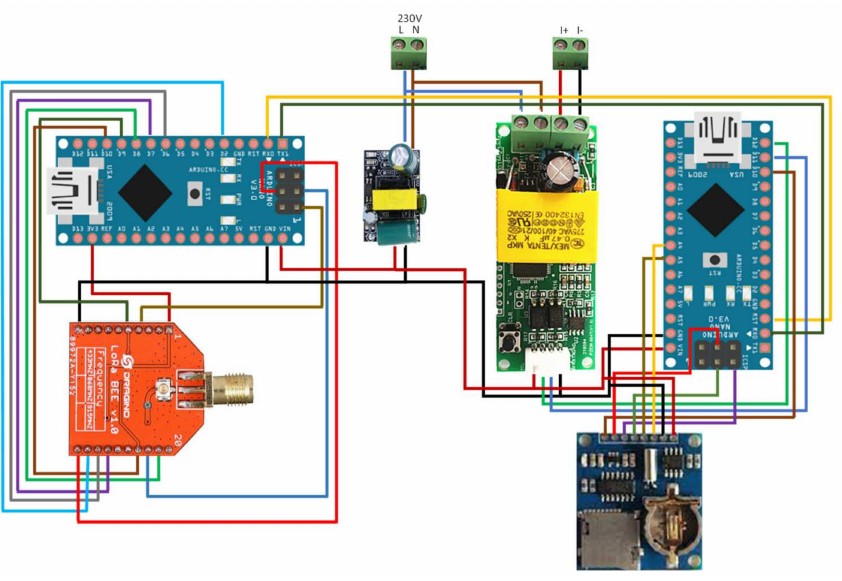
Figure 6. Wiring diagram of the EVMDHL.